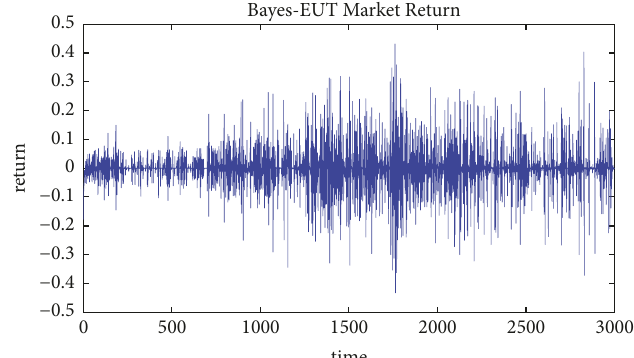
Figure 2: Logarithmic return of market.